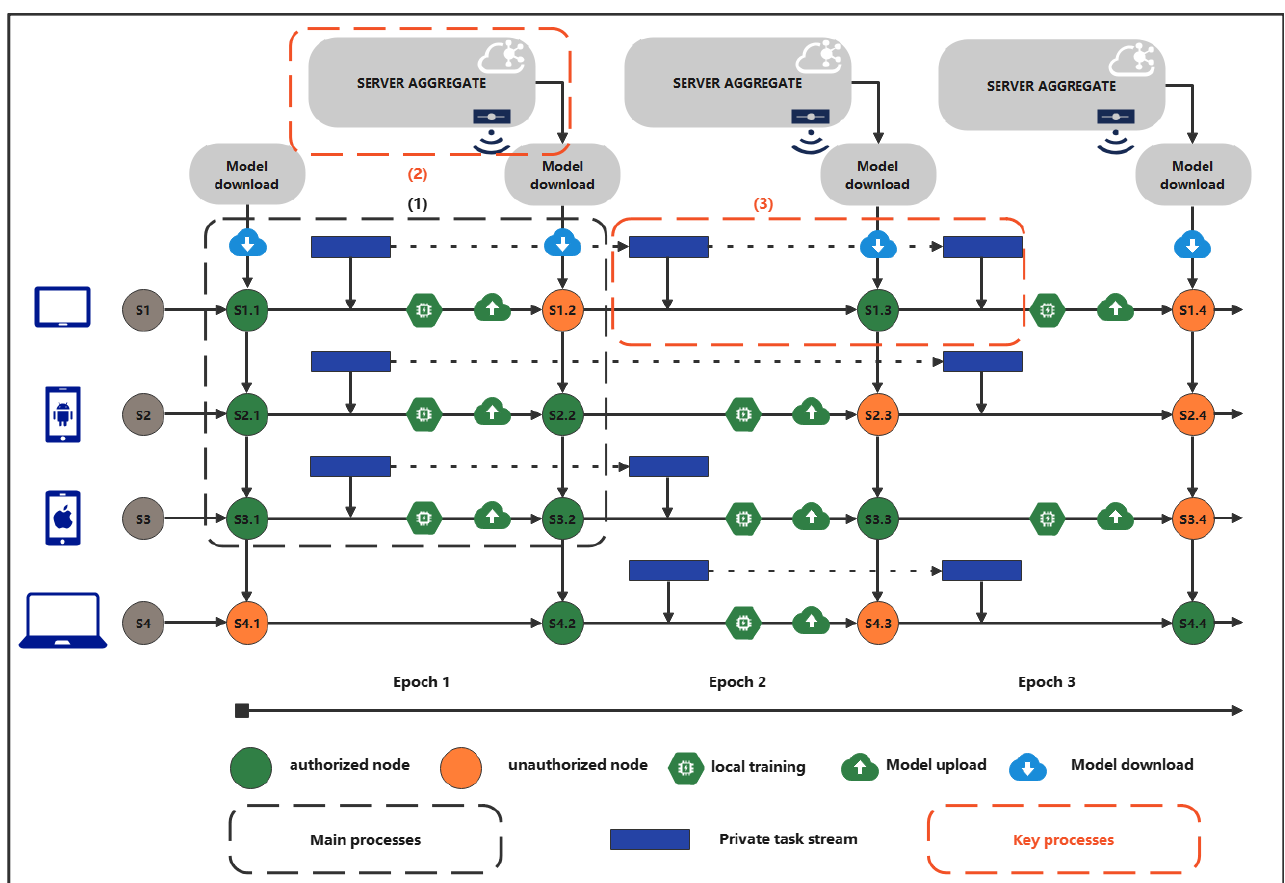
Figure 2. New generation federated learning